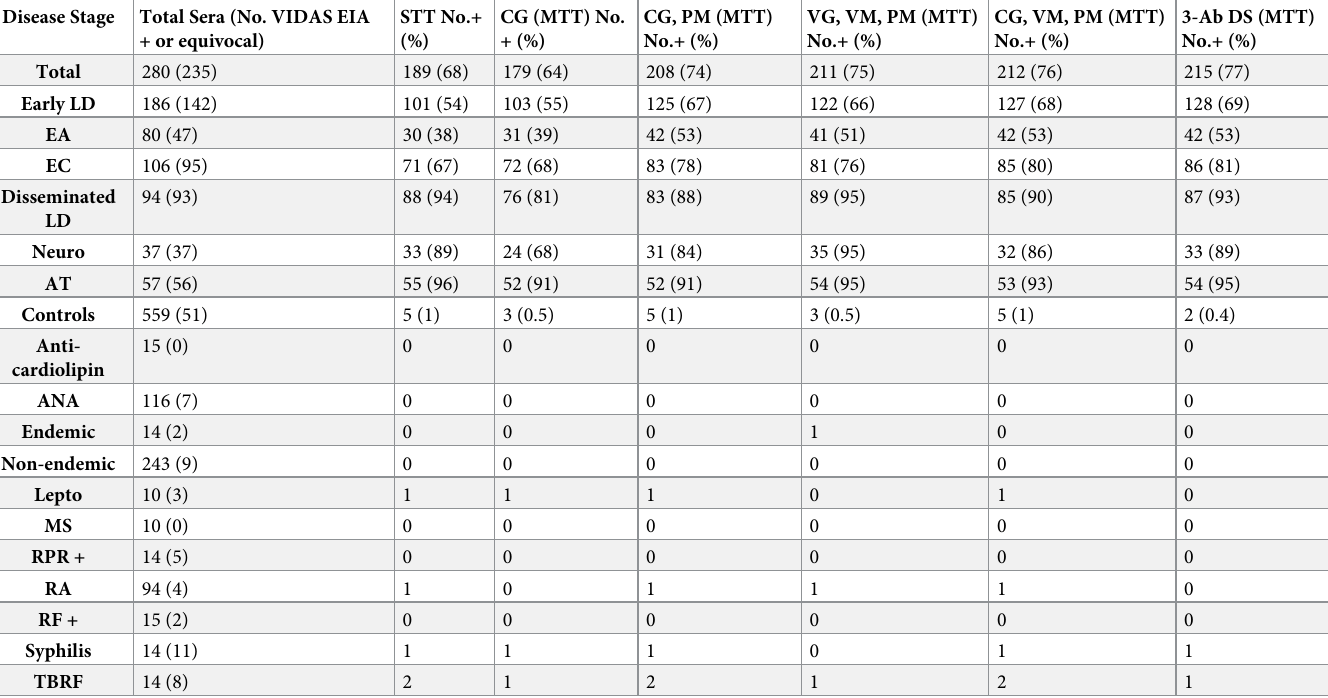
Table 6. STT performance versus modified 2-tiered approaches using C6-IgG, select binary models, and the 3-antibody diagnostic score as second-tier assays a,b . Disease Stage Total Sera (No. VIDAS EIA + or